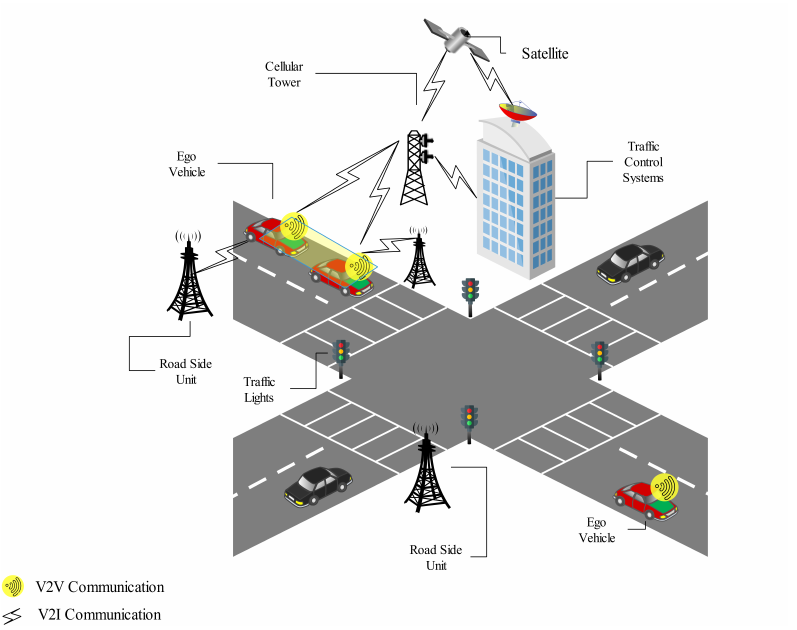
Figure 1. Overview of the ITS